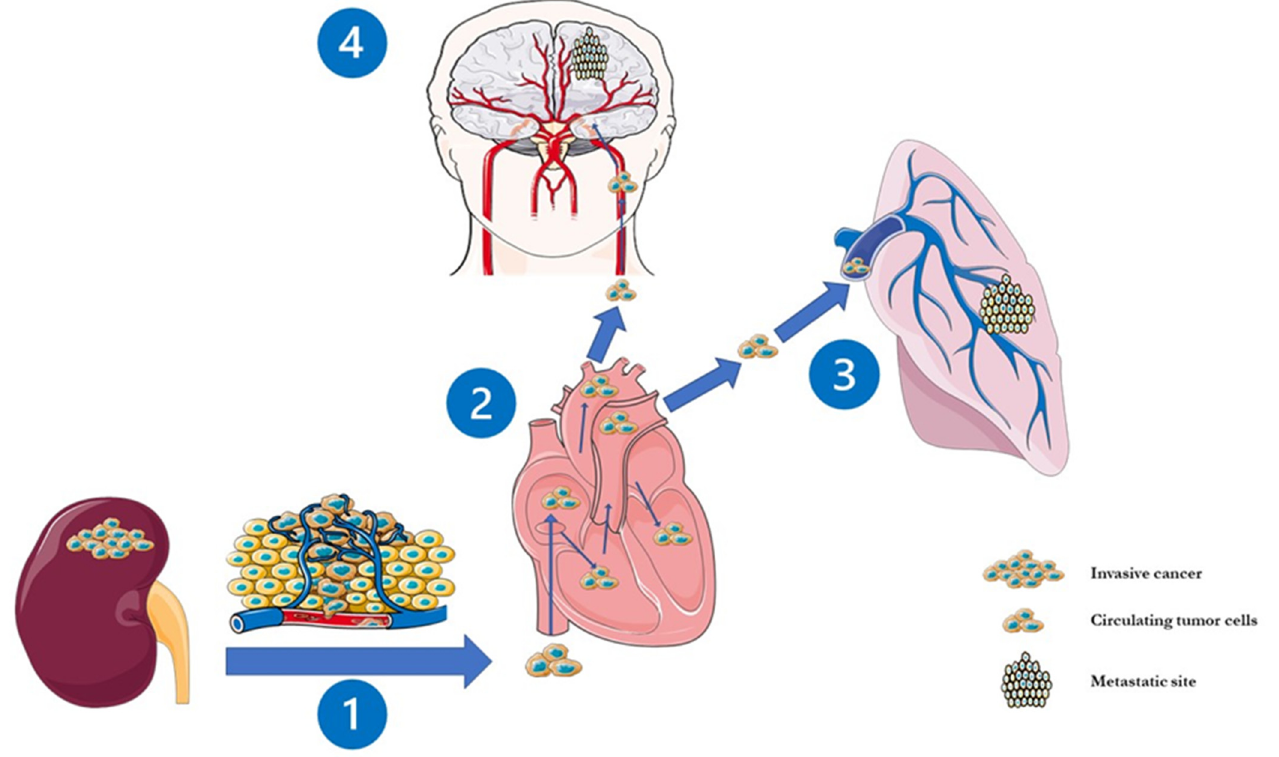
Figure 1. The cava-pathway and subsequent steps in the development of brain metastasis in renal cell carcinoma. The metastatic spread seems to begin with RCC-derived microvesicles CD105+ which break off from the primary tumour site and disseminate through the cava-type hematogenous pathway in 75% of the cases ( 1 ). Then, these microvesicles, carrying a cancer stem cell phenotype which stimulate angiogenesis, are transported through the right heart ( 2 ) into the pulmonary capillaries and ( 3 ) arterial circulation and finally attain the cerebral vasculature ( 4 ).